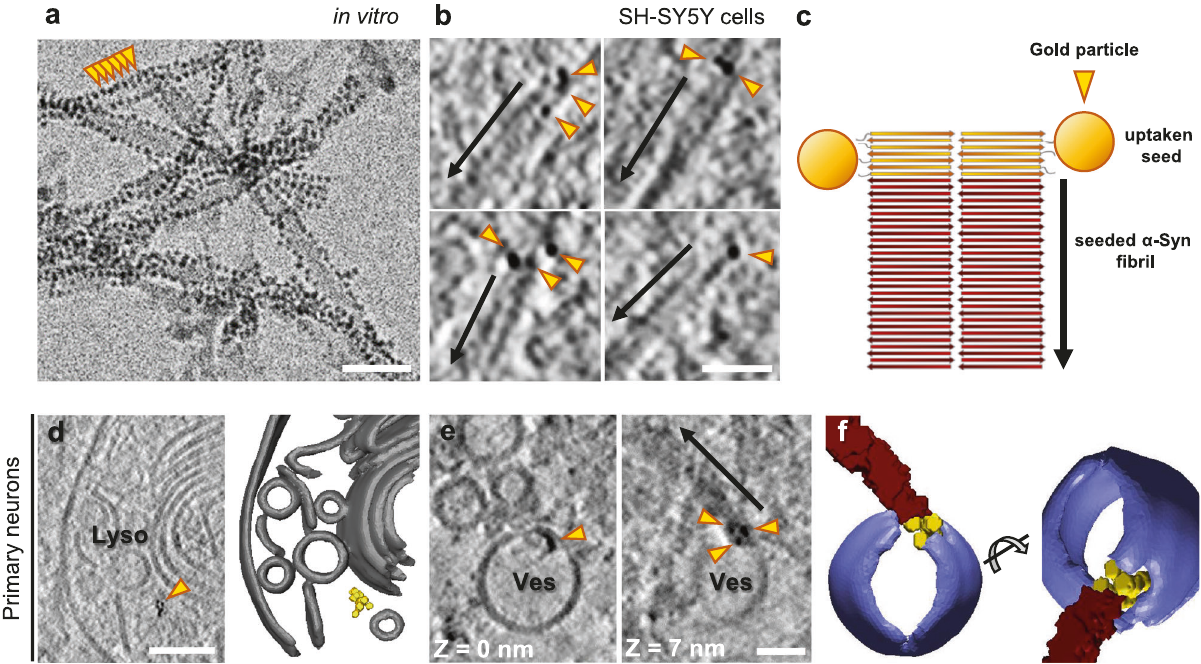
Fig. 3 Seeding of α -Syn aggregates by gold-labeled PFFs. a Cryo-electron microscopy image of PFFs labeled with 3-nm gold beads (orange arrowheads) via NHS esteri fi cation. Scale bar: 30 nm. Three biologically independent experiments were performed. The average distance between gold bead centers was 35 ± 4 Å (mean ± sd). Considering a typical distance between β strands of ~4.8 Å within α -Syn fi brils 33,34 , this corresponds to labeling every seventh or eighth β -strand on the fi bril. b Tomographic slices (thickness 1.8 nm) showing α -Syn fi brils seeded by gold-labeled PFFs within SH-SY5Y cells expressing GFP- α -Syn. Arrows mark the direction of fi bril growth from the gold-labeled seed. Scale bar: 40 nm. Two biologically independent experiments were performed. c Schematic of the hypothetical molecular organization of α -Syn fi brils seeded by gold-labeled PFFs. d A tomographic slice (thickness 1.4 nm; left) and 3D rendering of the tomogram (right) showing gold-labeled PFFs within the lumen of a lysosome in a primary neuron expressing GFP- α -Syn. Lyso; lysosome. Lysosomal membranes (gray), gold particles labeling the PFF (yellow). Scale bar: 70 nm. e Tomographic slices (thickness 1.4 nm) at different Z heights showing gold-labeled PFFs found within the membrane of a vesicle (Ves) and seeding an α -Syn fi bril (arrow) in a primary neuron expressing GFP- α - Syn. Scale bar: 30 nm. Two biologically independent experiments were performed. f 3D rendering of the tomogram depicted in e in two different orientations. Vesicle membrane (purple), α -Syn fi bril (red), gold particles (yellow). Representative images are shown in a , b , d , e , and f